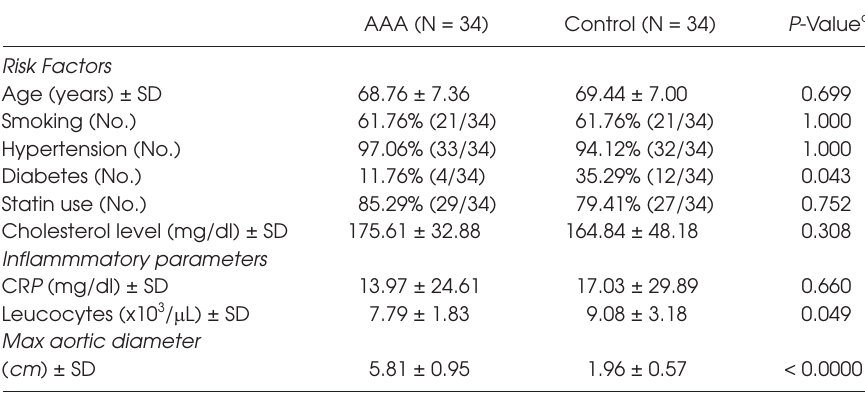
Table 1B: Characteristics of patients with AAA and non-AAA